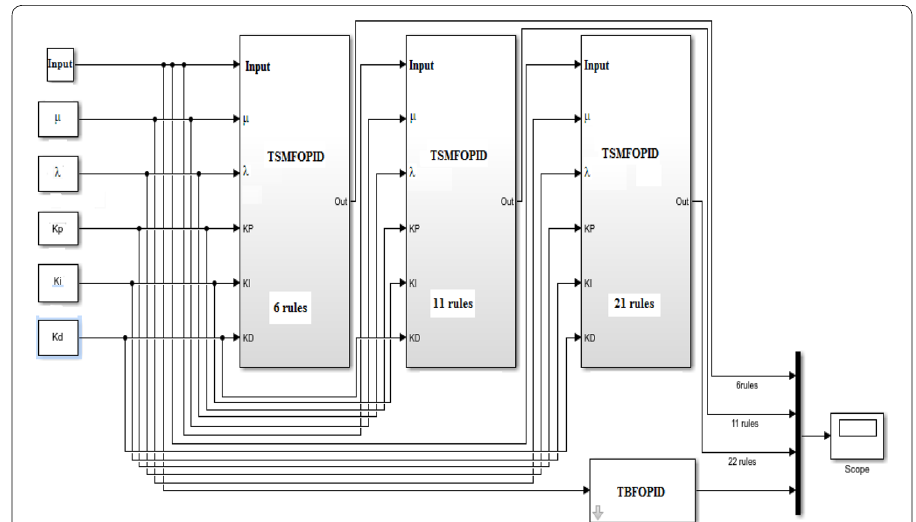
Fig. 7 TSMFOPID controller with 6, 11 and 21 memberships